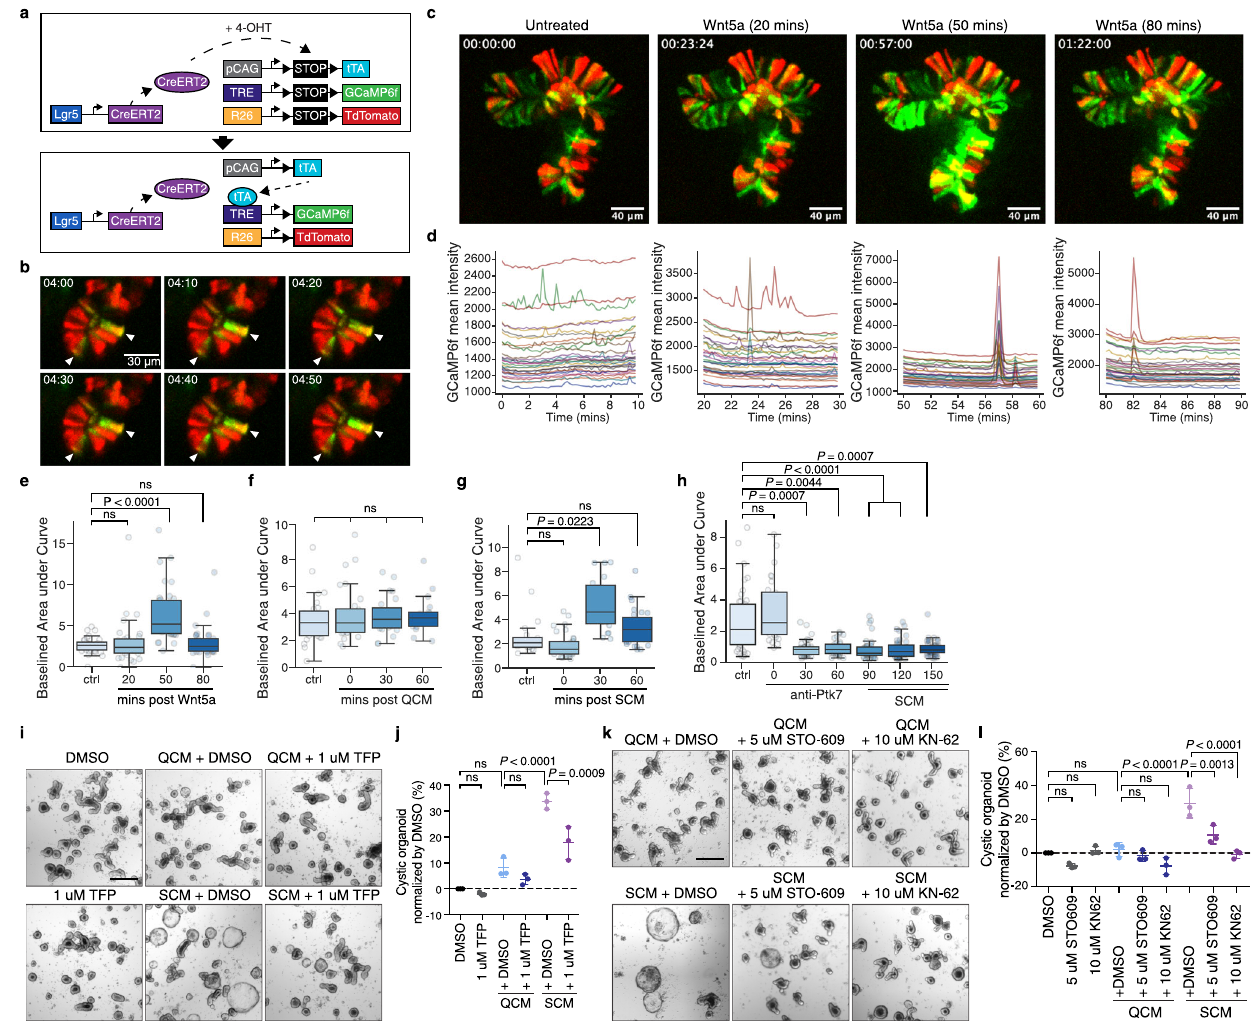
Fig.5|Ptk7modulatescytosolicCa 2+ oscillationsinintestinalorganoids.a Lgr5- CreERT2-mediated expression of GCaMP6f in this experiment. Cre removes stop cassettes upon addition of 4-OHT, allowing expression of tTA, GCaMP6f, and tdTomato. b Time lapse images showing Ca 2+ fl ashes in the crypt domain of a mouse intestinal organoid. GCaMP6f and tdTomato expression is shown in green and red, respectively. Scale bar, 30 μ m. c Representative frames from live